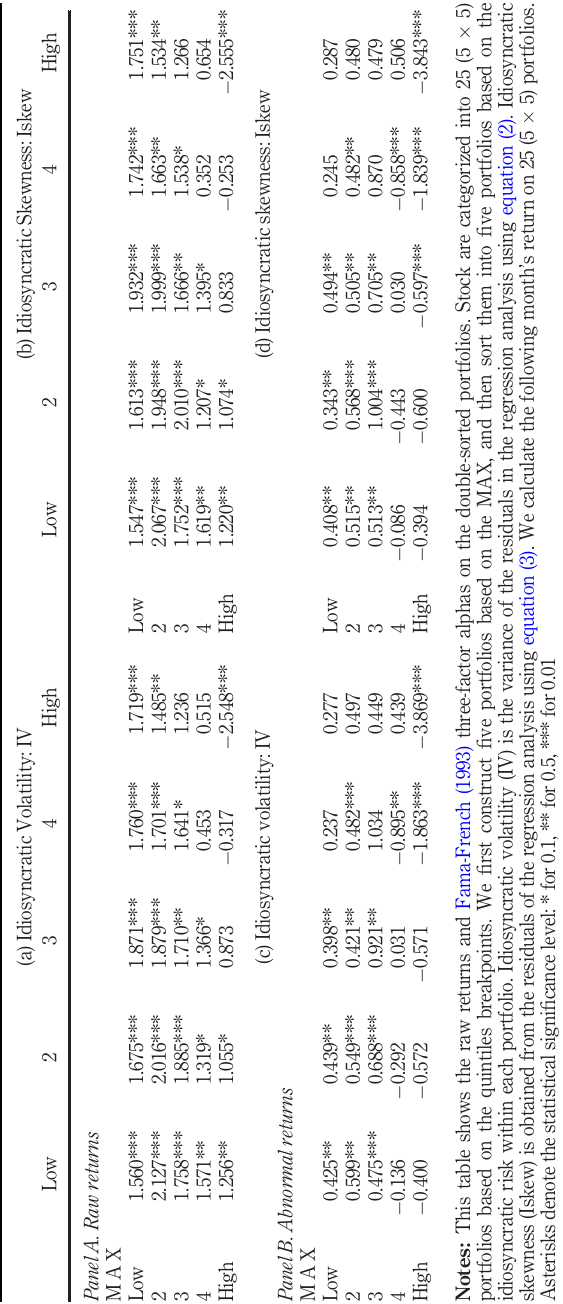
Table 5. Returns on portfolios on stocks sorted by MAX and idiosyncratic